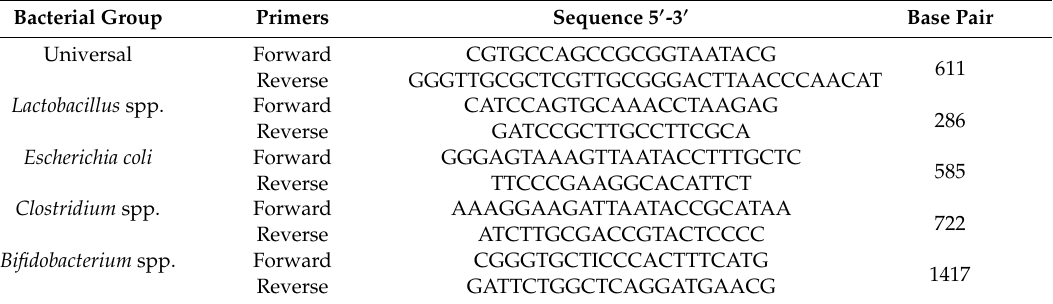
Table 2. Sequences of primers used for amplification of bacterial 16S rRNA gene.